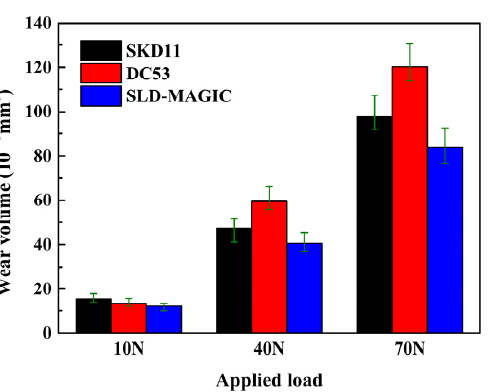
Figure 9. Wear volume of SKD11, DC53 and SLD-MAGIC steels under different normal loads of 10 N, 40 N and 70 N.